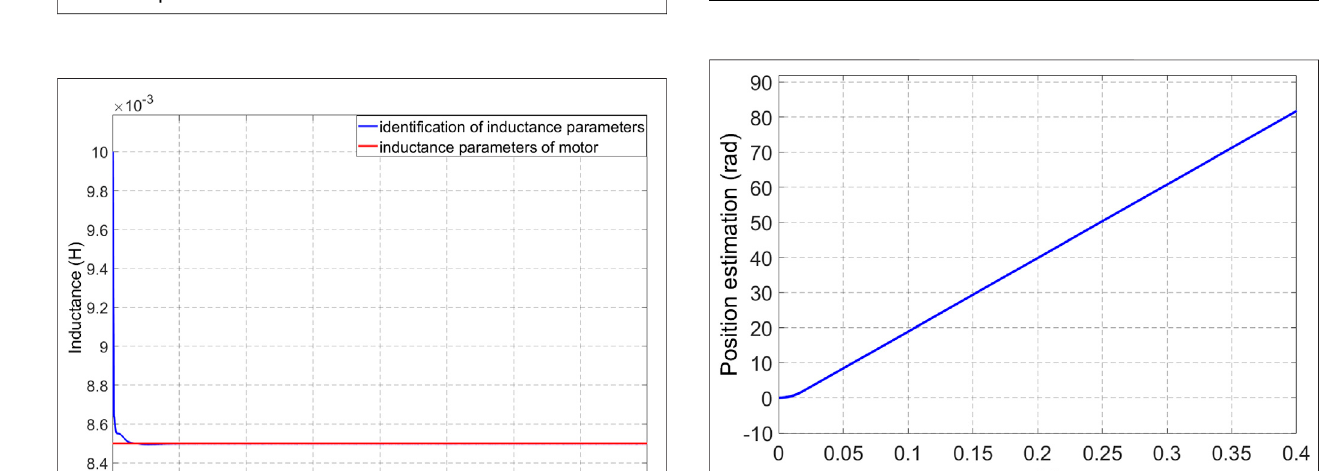
FIGURE 8 | Flux identi fi cation value.